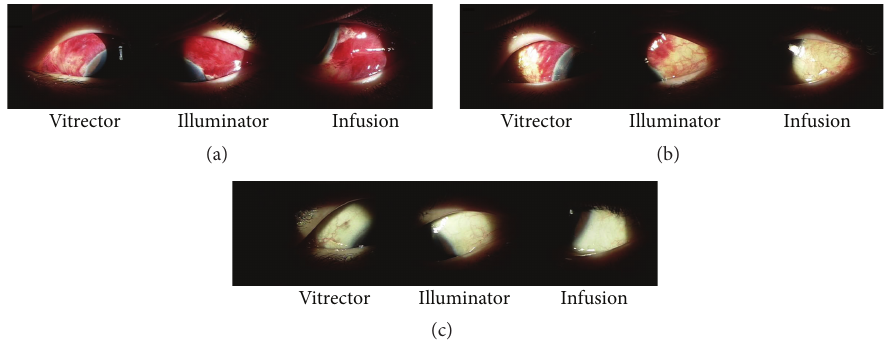
Figure 2: Postoperative anterior segment photos from operation in a 52-year-old woman. (a) Mild chemosis and subconjunctival hemorrhage wereobservedatallthreeareas,andtheintraocularpressurewas23 mmHgonpostoperativeday1.(b)Subconjunctivalhemorrhagedecreased, and the intraocular pressure was 17 mmHg at 1 week after operation. (c) Anterior slit lamp photos showed clear conjunctiva at 1 month after operation, and the intraocular pressure was 18mmHg.